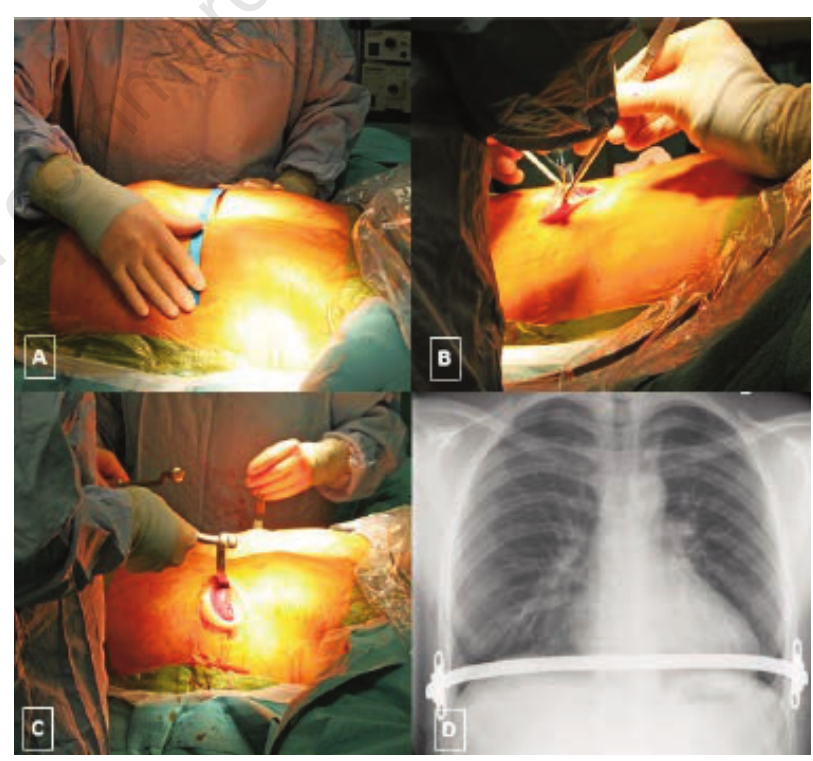
Figure 4. Minimally invasive repair of a pectus excavatum deformity with a NUSS tech- nique. Images demonstrating: measuring of the bar (A), minimal access incision (B), the bar in situ prior to flipping (C) and a chest radiograph performed post-operatively